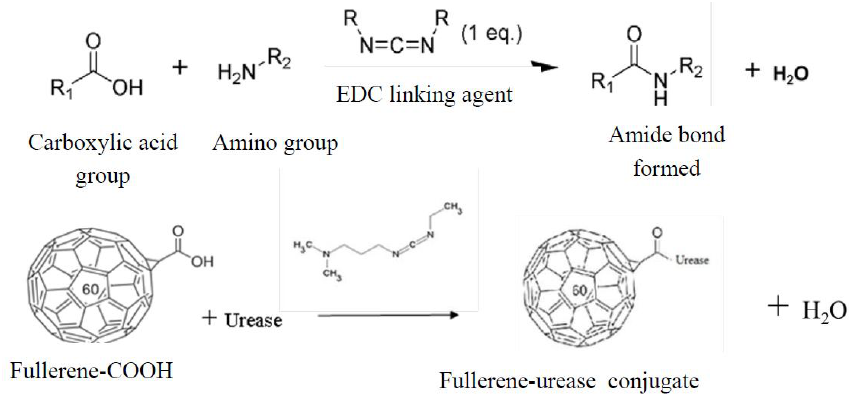
Figure 3. Schematic mechanism of reaction between modified fullerene and urease enzyme.